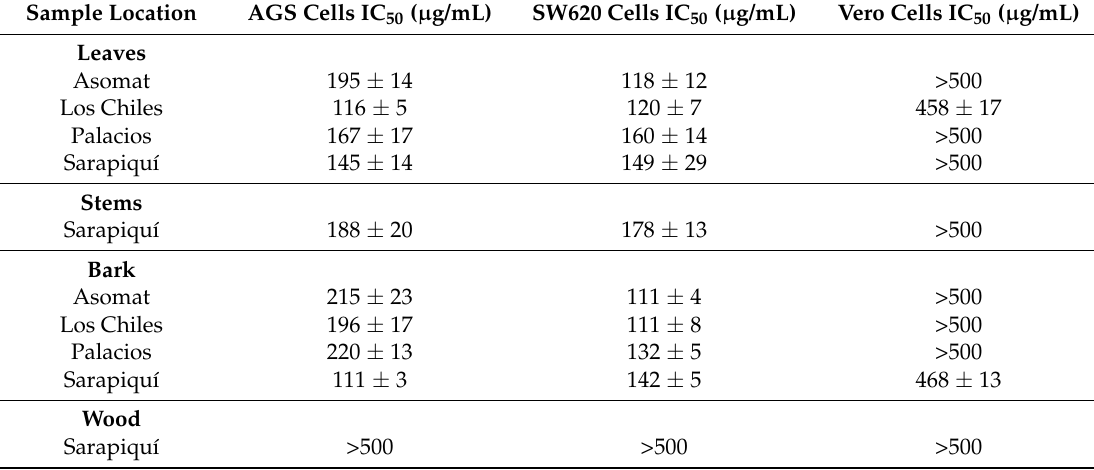
Table 3. Cytotoxicity of U. tomentosa extracts to gastric (AGS) and colon (SW620) adenocarcinoma cells as well as to control Vero